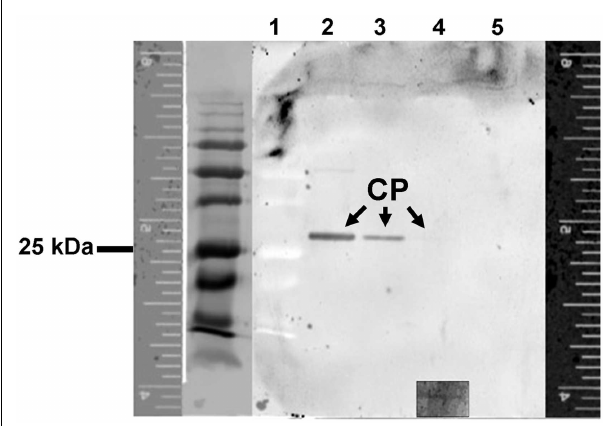
FIGURE 2 | Immunoblot and fluorescent imaging analysis to determine the recognition specificity between LIYV virions and biotinylated-anti-LIYV IgG via streptavidin quantum dot 605 binding. Lane 1, low molecular weight prestained standards (the lane to the immediate left of lane 1 is an image of lane 1 captured under transmitted light); lanes 2–5, LIYV virions (1200, 120, 12, and 1.2ng, respectively). Fluorescence rulers are included to provide a reference for the migration distance of proteins detected under fluorescence and transmitted light.The positions of the major coat protein (CP) of LIYV are indicated.The inset at the bottom of lane 4 is an image of the position in the membrane at which the CP was detected at a higher PMT of 500V.The position of a 25kDa prestained protein standard is as